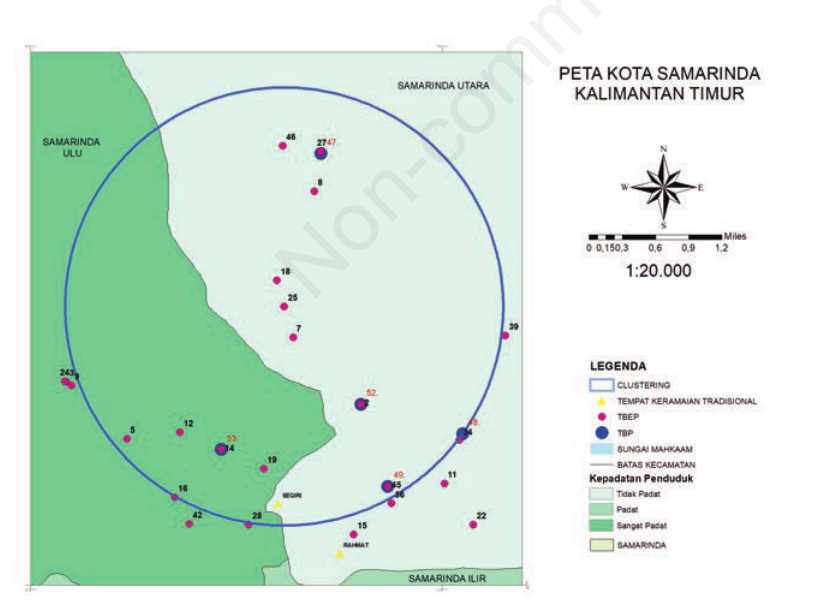
Figure 2. Distribution patterns of EPTB and pulmonary TB patients in Samarinda City. One clustering in 17 patients was obtained from EPTB and pulmonary TB analysis, which consisted of 5 pulmonary TB patients and 12 EPTB patients centered on - 0.458159 S / 117.149945 E with a radius of 3.19 km. The formation of clustering indi- cated there is a geographical relationship between EPTB and pulmonary TB in Samarinda city. Based on Purely Spatial analysis with the Bernoulli model, a relative risk of 5.29 is